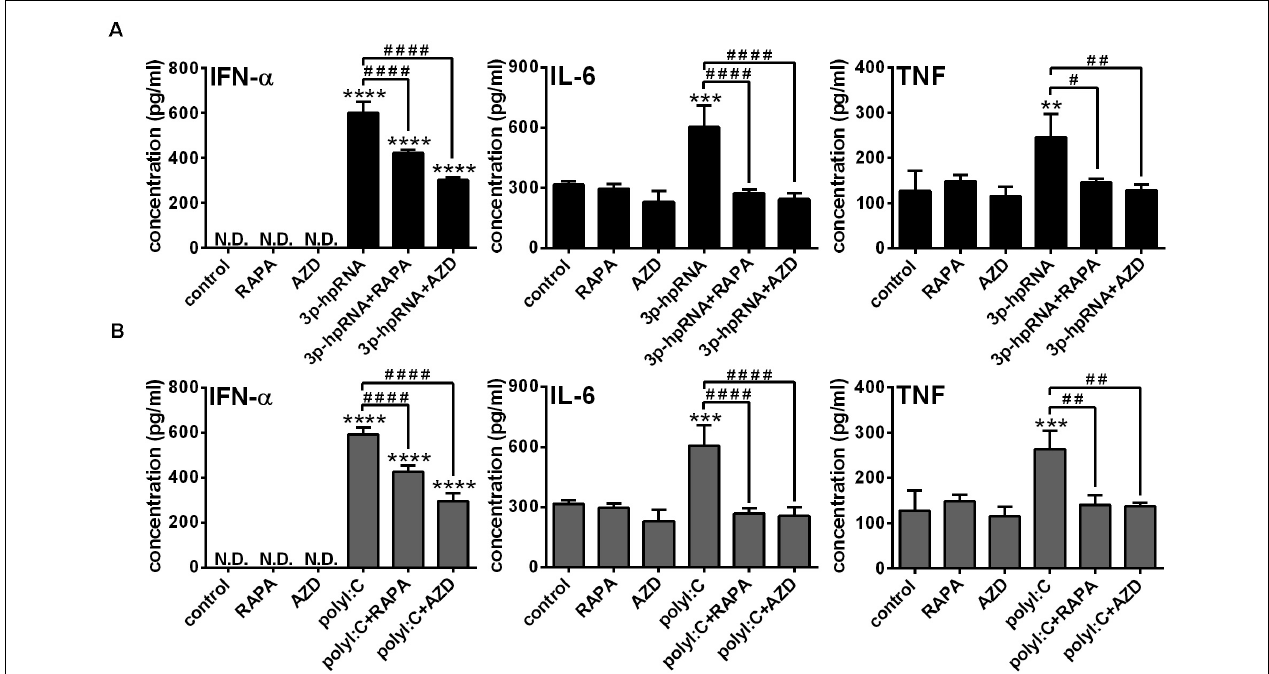
FIGURE 8 | The RLR-stimulated secretion of IFN- α and pro-inflammatory cytokines is abolished upon mTOR blockade in primary human pDCs. Primary pDCs were pre-treated with vehicle control, 100 nM rapamycin (RAPA) or 100 nM AZD8055 (AZD) for 2 h and then stimulated with 3p-hpRNA (0.5 µ g/ml) (A) or polyI:C (1 µ g/ml) (B) . (A,B) IFN- α , IL-6 and TNF protein levels were measured by ELISA 6 h after stimulation. Data are shown as mean ± SD from 3 independent experiments. ** p < 0.01, *** p < 0.01, **** p < 0.0001 vs. control; # p < 0.05, ## p < 0.01, #### p < 0.0001. ND, not